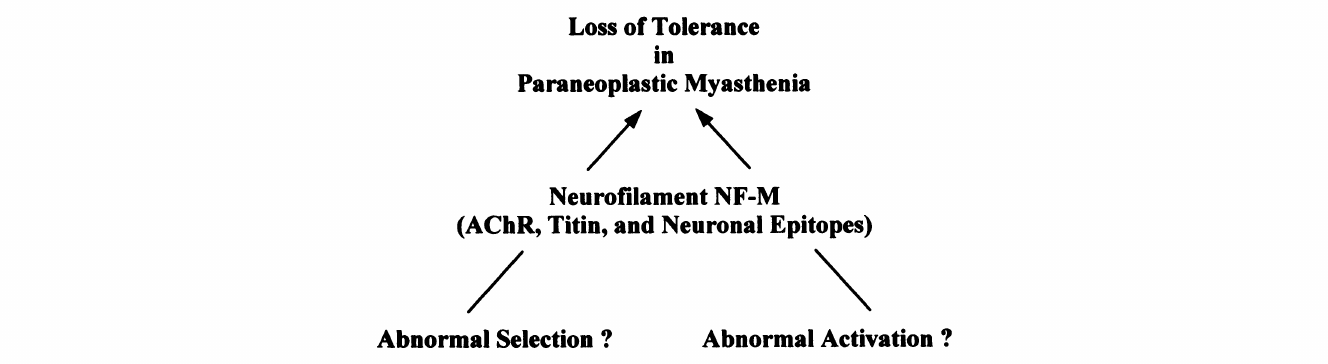
Hypotheses to explain the restricted autoimmune response against the AChR, titin, and neuronal structures regarding the fact that neither AChR nor titin are expressed in MG-associated thymic epithelial tumors. Cross-reacting epitopes of the AChR and titin occurring in the abnormally expressed 160-kD neurofilament (NFM) might elicit T-cell autoreactivity either by abnormal selection or an abnormal stimulation of T